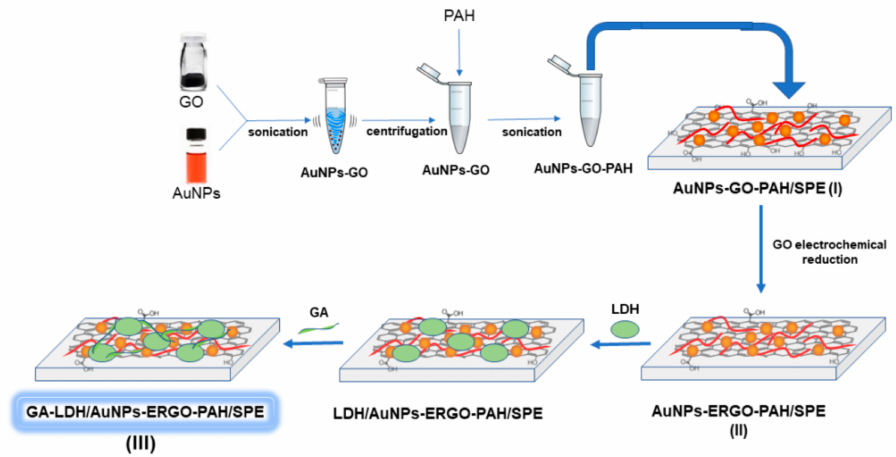
Figure 1. Schematic representation of the GA-LDH/AuNPs-ERGO-PAH/SPE biosensor